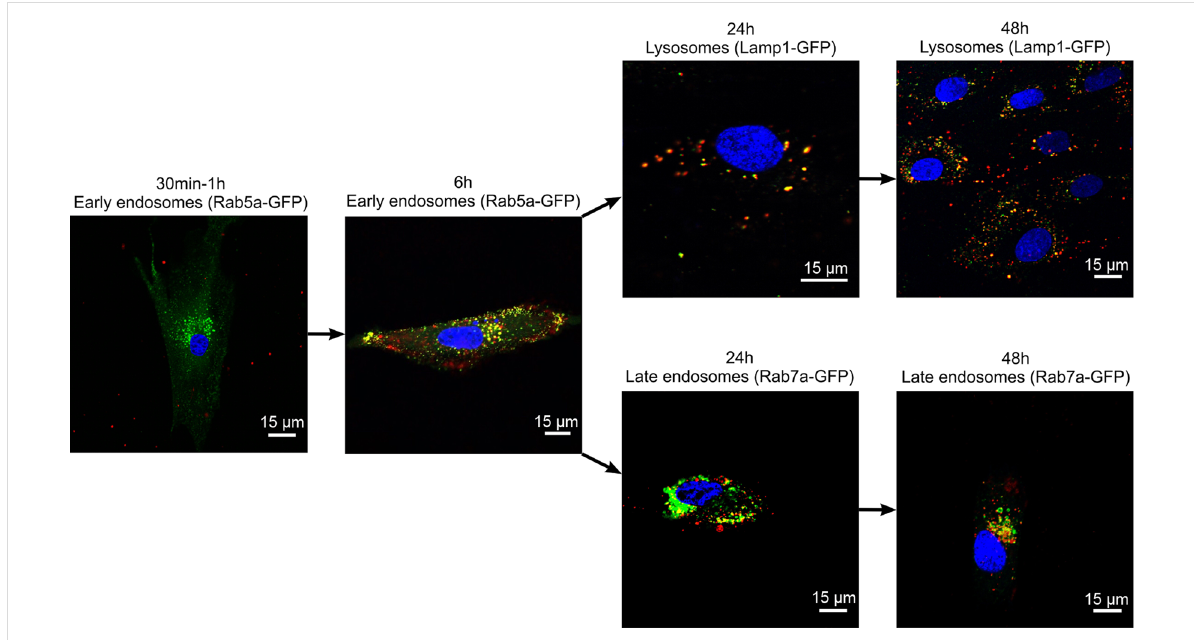
Figure 8: QD co-localization with endosomal compartments. Three overlaid channels represent the nucleus (blue), carboxyl QD655 (red) and Rab5a- GFP (early endosomes), Lamp1-GFP (lysosomes) or Rab7a-GFP (late endosomes) (green). Yellow colour demonstrates co-localization. Representa- tive data are